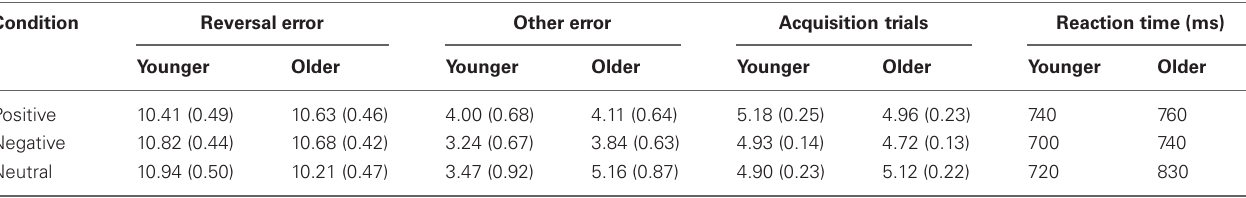
Table 1 | Behavioral results showing no significant differences between group and